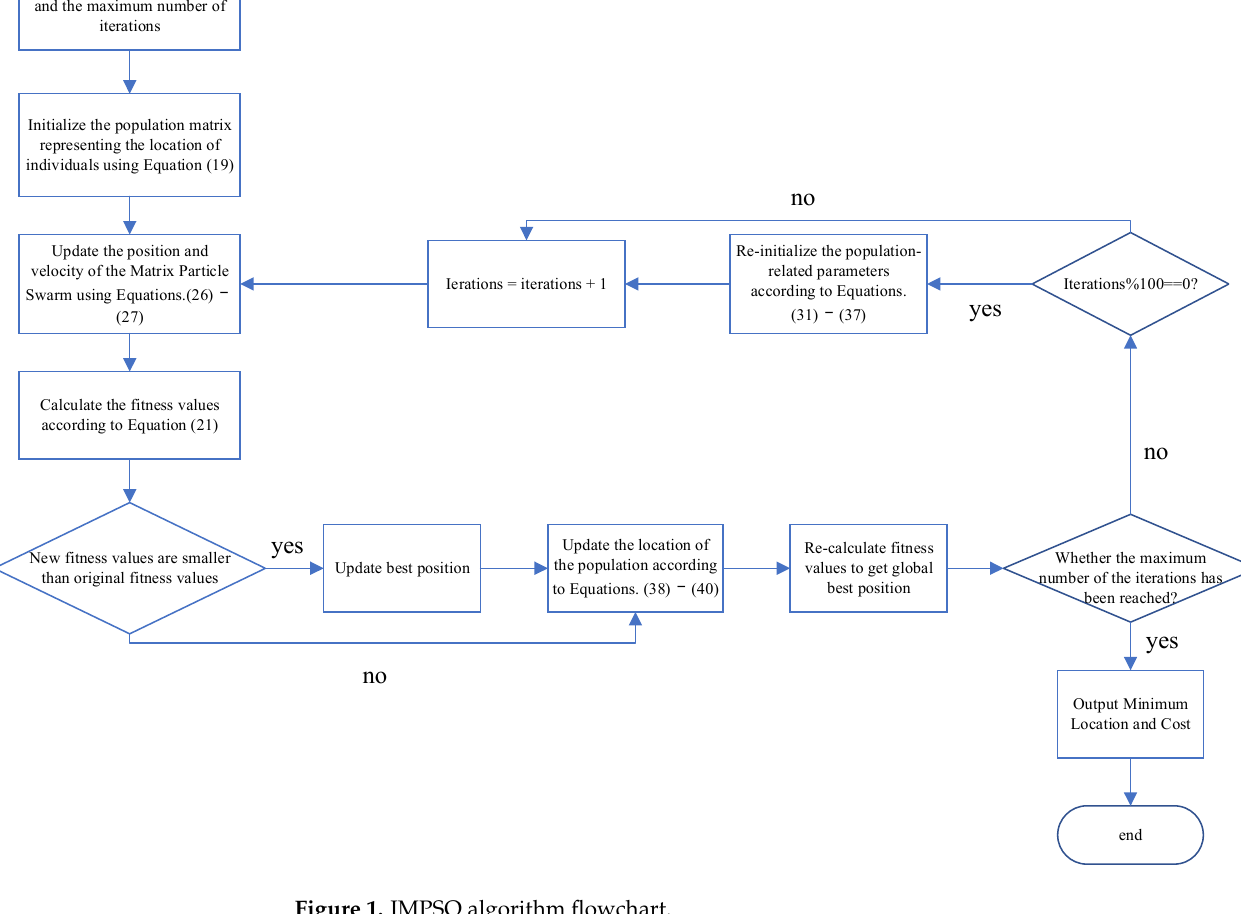
Figure 1. IMPSO algorithm flowchart .